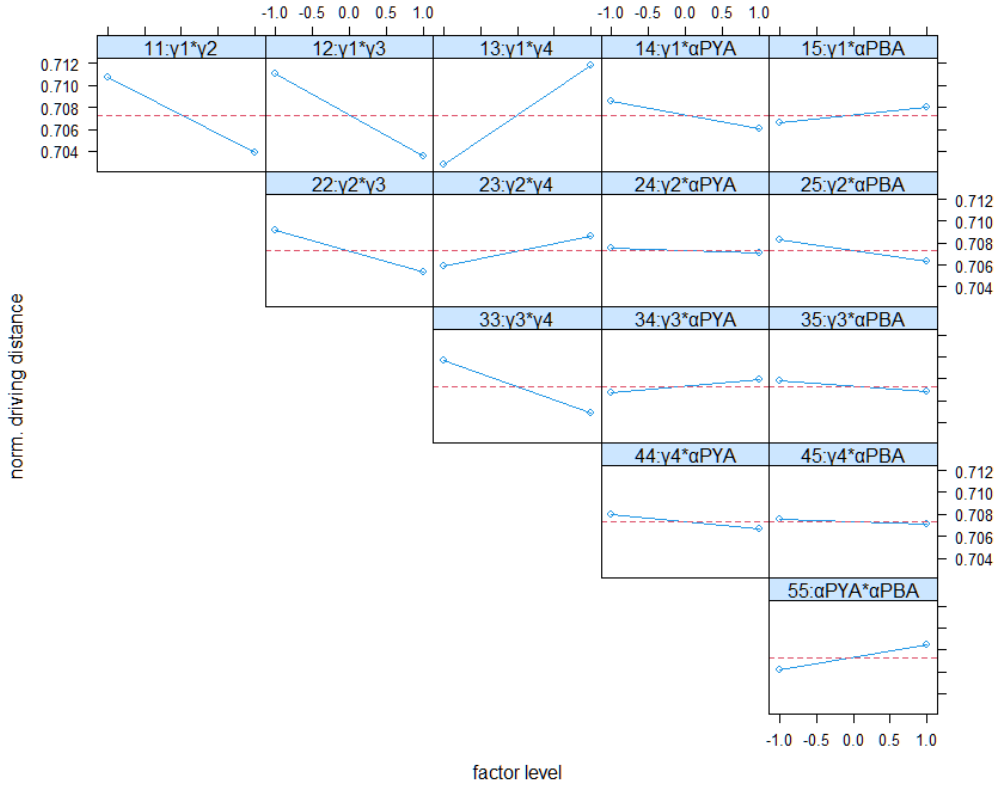
Figure 14. Factor interactions on norm. Driving distance in the real-data-based model.